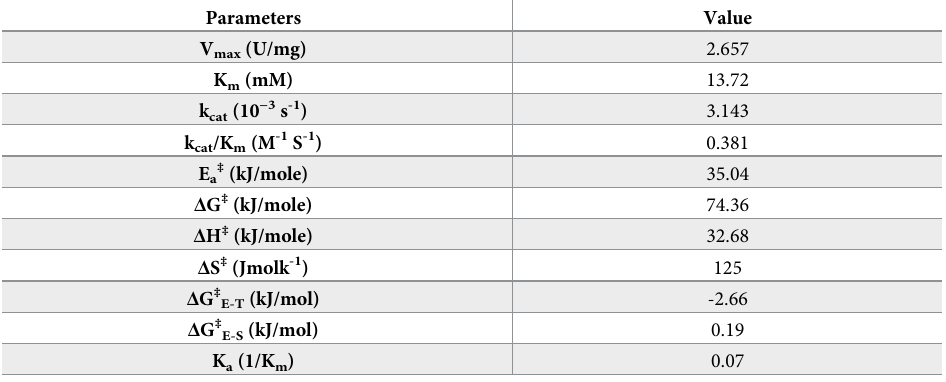
Table 2. The thermodynamic parameters for protease 1147 reaction activation